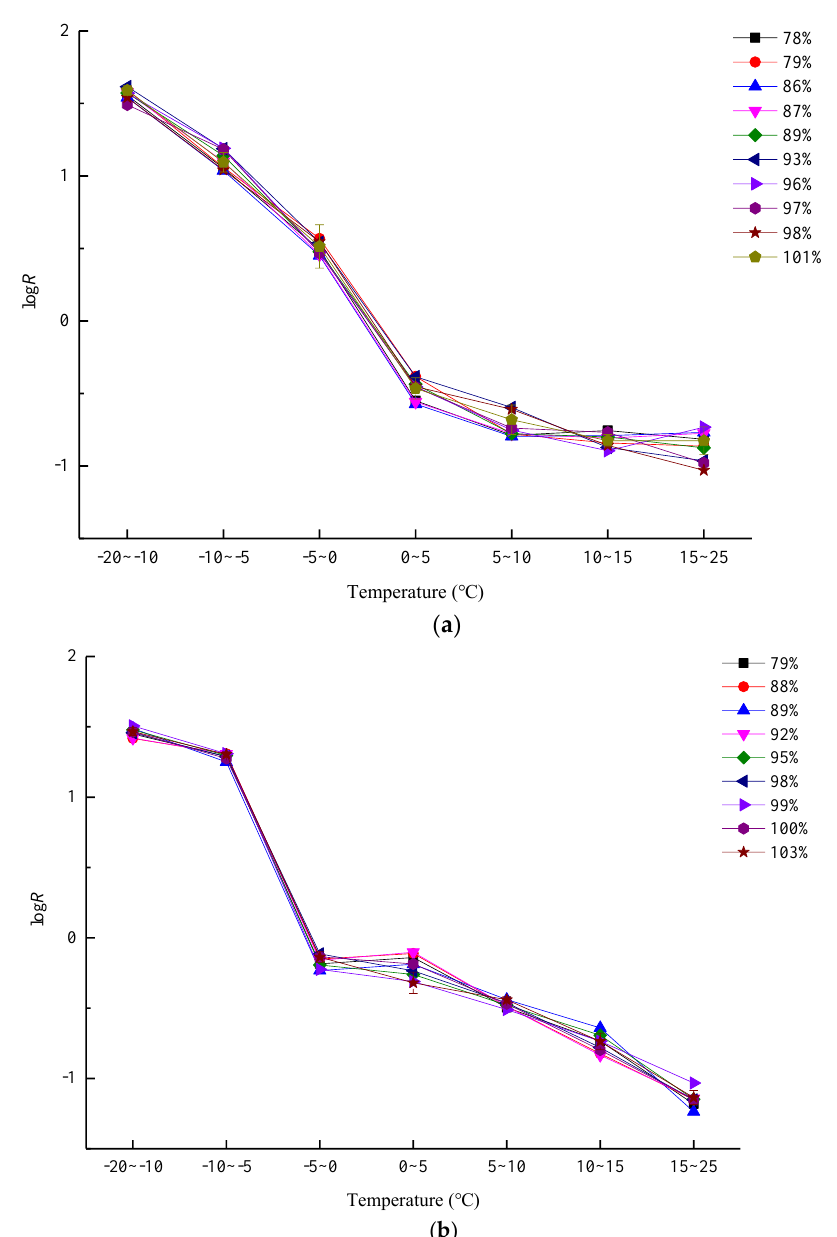
Figure 4. Effect of temperature on the logR in the cross-section of Larix gmelinii trees under different MCs. ( a ) Sound Larix gmelinii trees; ( b ) Decayed Larix gmelinii